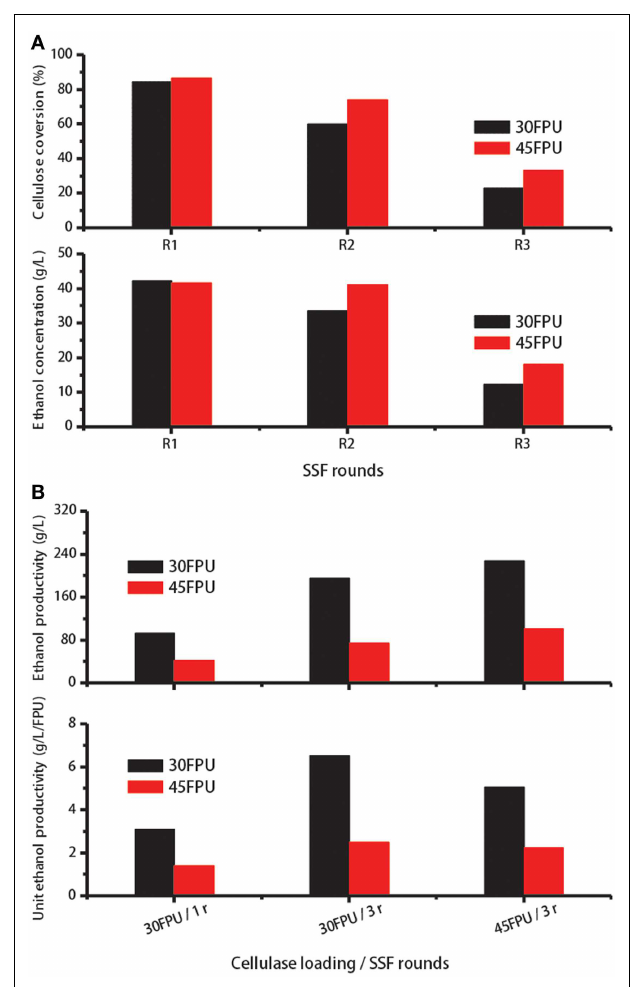
FIGURE 5 | (A) Cellulose conversion and ethanol concentration during enzyme recycling for three consecutive SSF cycles. (B) Cellulase activity utilization coefficient (gram per Litre) and specific activity utilization coefficient (gram per Litre per filter paper unit) verses different cellulase loadings and different SSF